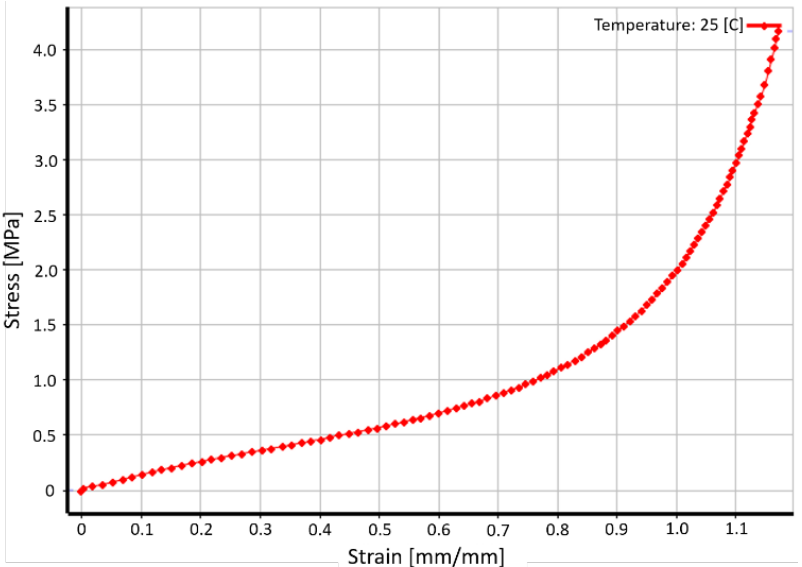
Figure 4. Approximation of the curve stress/strain by the Mooney–Rivlin 5 Parameter model. The geometry for this simulation represents only the channel wall that has 0.15 mm of thickness.